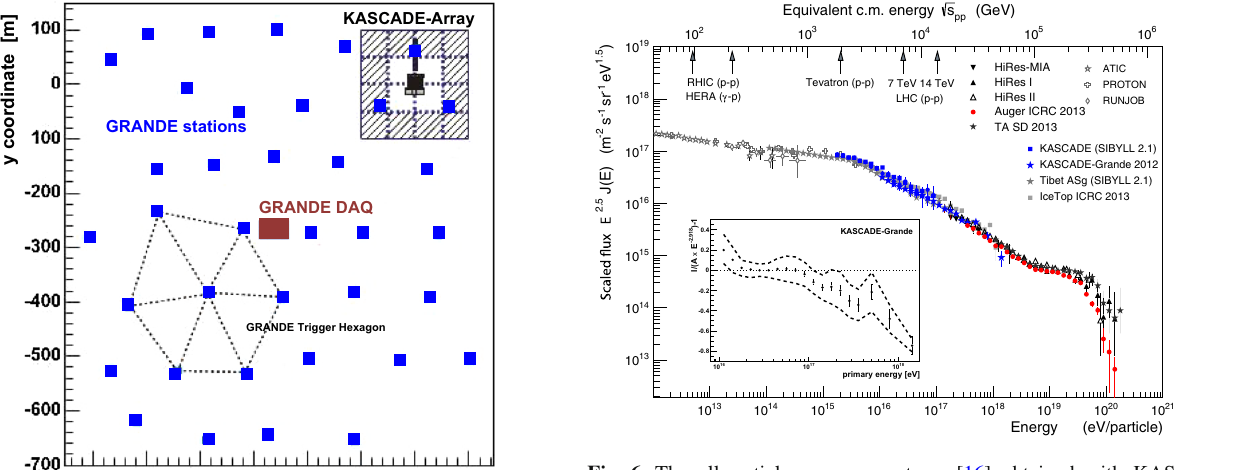
Fig. 6 The all-particle energy spectrum [16] obtained with KAS- CADE and KASCADE-Grande (based on the QGSJet-II model and unfolded, i.e. corrected for the reconstruction uncertainties). Shown are the spectra in comparison with results of other experiments. In addi- tion, the corresponding interaction energy at accelerators are indicated. The inlet shows the residuals of the all-particle energy spectrum from KASCADE-Grande with systematic